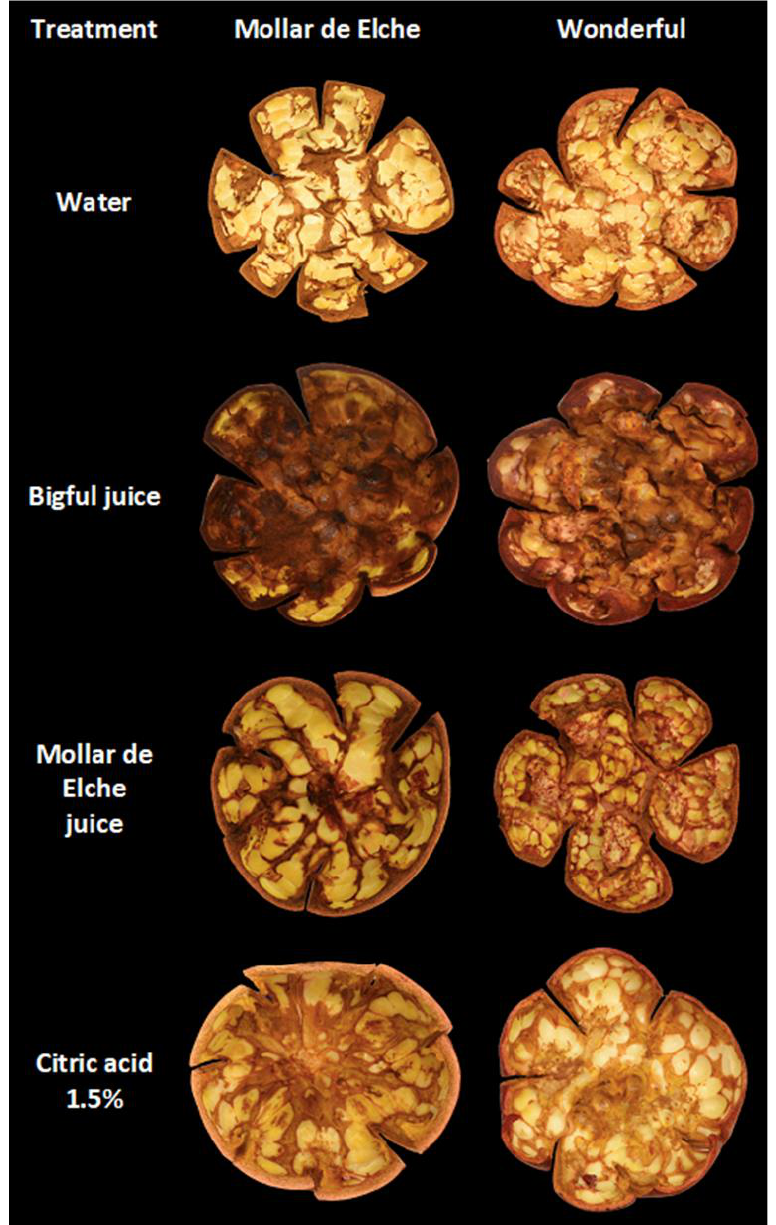
Figure 6. Internal aspect of ‘Wonderful’ and ‘Mollar de Elche’ peels treated with water, ‘Bigful’ or ‘Mollar de Elche’ juices, and citric acid at 1.5%, after 15 d at 2